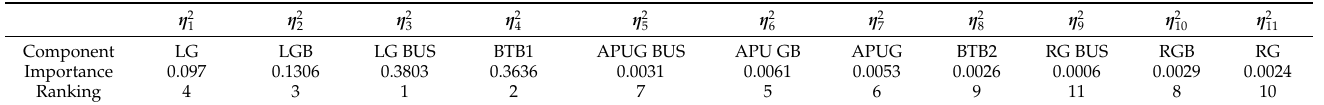
Table 4. Calculation of the importance of the failure rate of each component of the power supply system ( T = 1000 h).